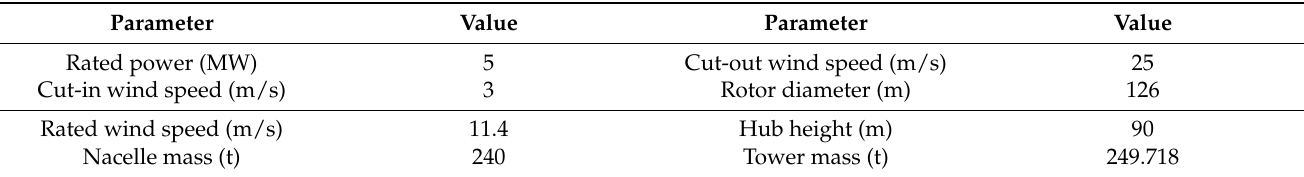
Table 1. Parameter of OC4-DeepCwind wind